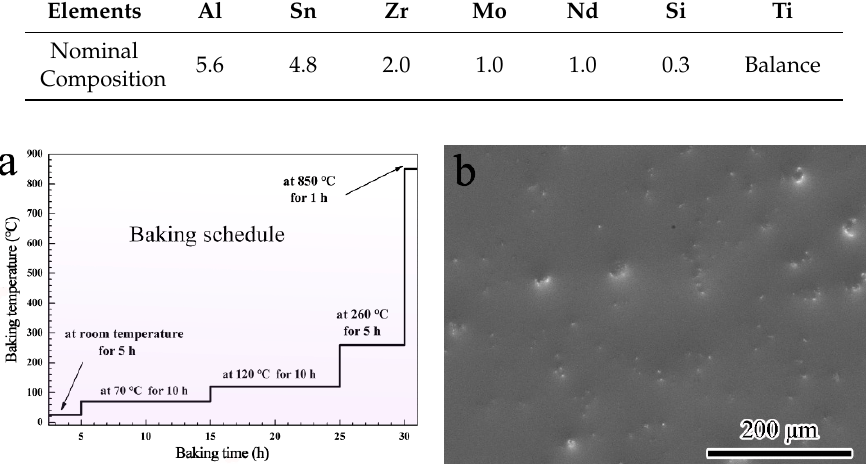
Figure 1. The baking schedule of the composite coating ( a ) and surface morphology of the coating after baking ( b ).